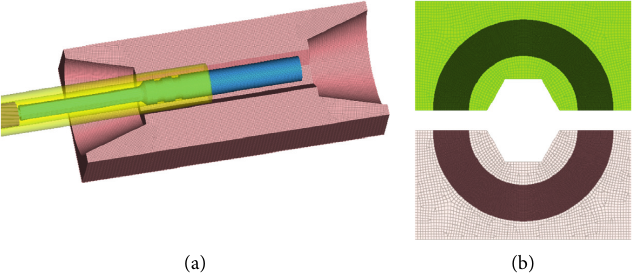
Figure 10: A finite element model for the crimping process of the stamper, aluminum pipe, and steel anchor: (a) overall view; (b) cross- sectional view.